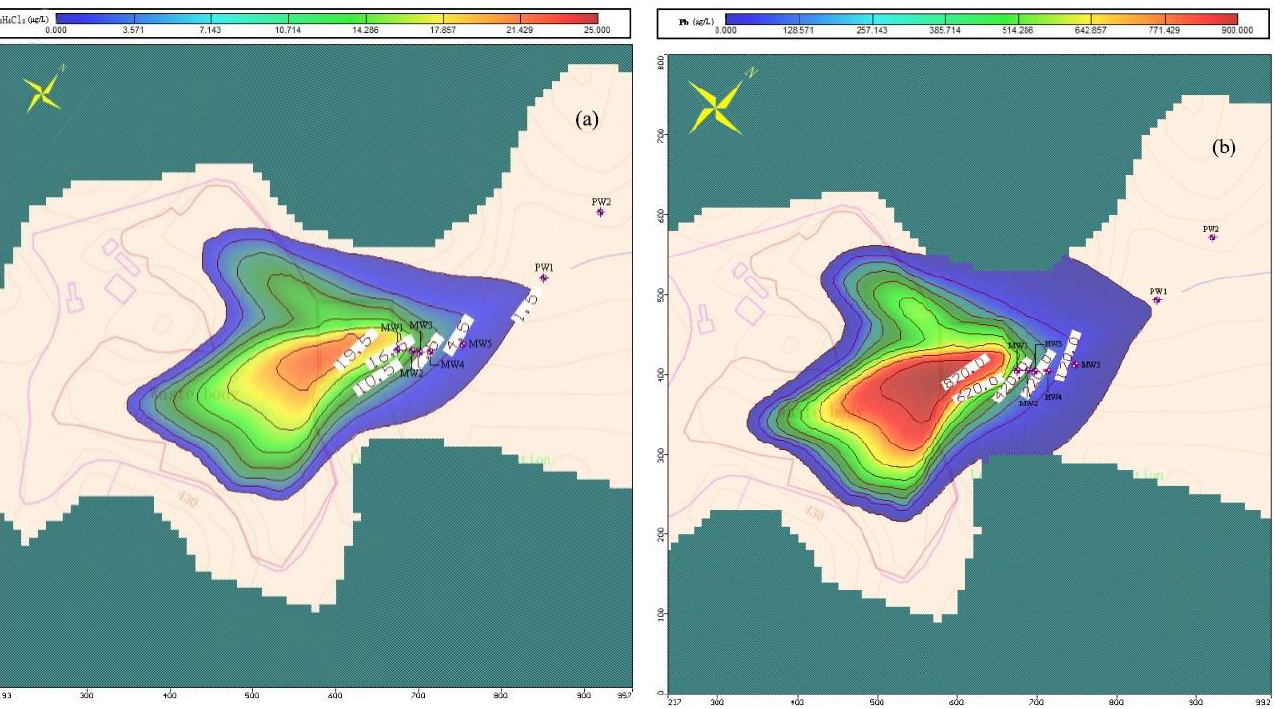
Figure 9. Spatial distribution of health risk assessment results. The maximum non-carcinogenic risk of Mn in the groundwater downstream of the landfill was 2.9 and the area with a HI value of more than 1 extended from the landfill to 50 m downstream, giving a total area of 3,565 m 2 . The maximum non carcinogenic risk of